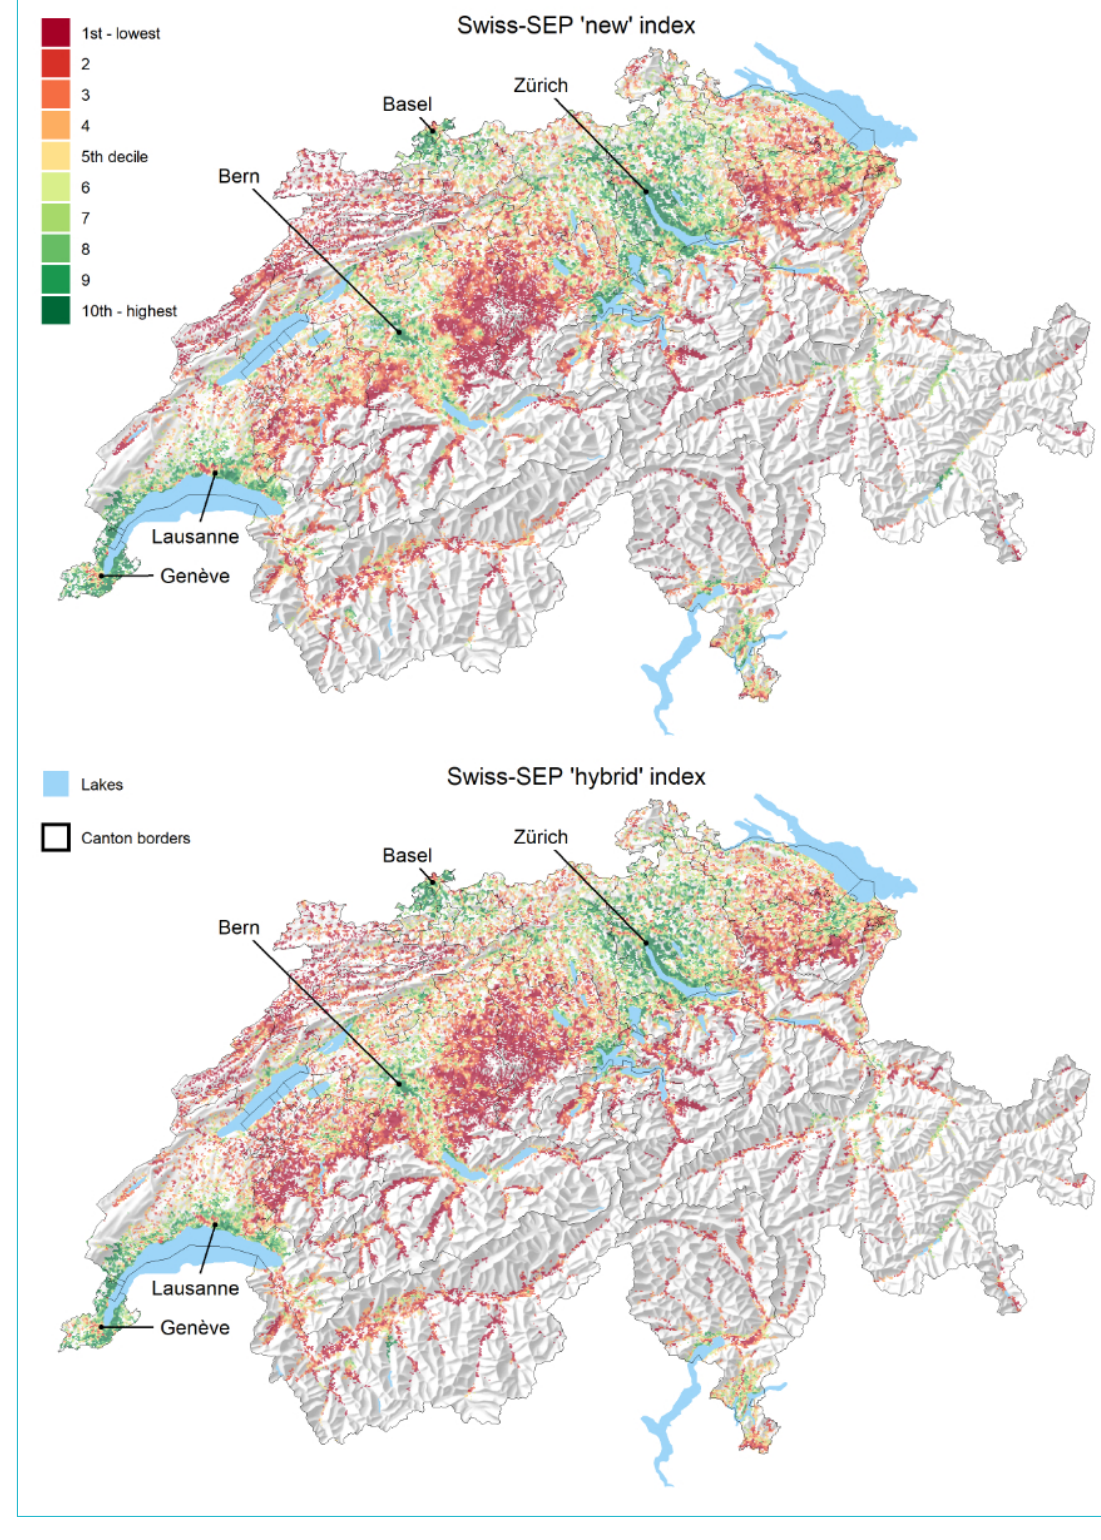
Figure 1: Map of the new (Swiss-SEP 2) and hybrid (Swiss-SEP 3) indices. The original values of 1.54 million neighbourhoods were aggregat- ed into a hexagonal grid with a cell size of 500 m to improve the figure’s clarity. Each grid displays the median value of index